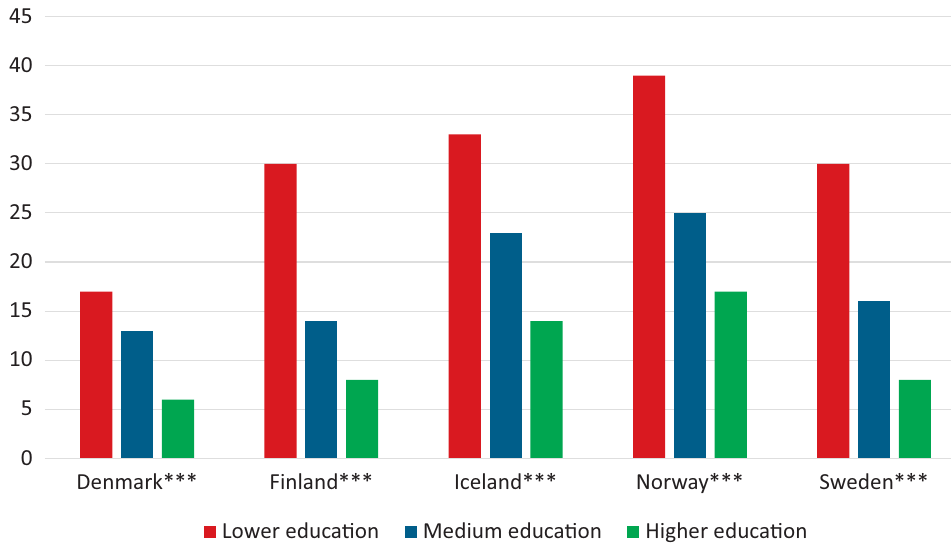
Figure 2. Percentage among different education groups agreeing that “when a mother works for pay, the children suffer” (all age groups, Nordic countries, 2017). Notes: *p < 0.05, **p < 0.01, ***p < 0.001; Denmark: n = 3,233, gamma = − 0.38; Finland: n = 1,164, gamma = − 0.45; Iceland: n = 1,997, gamma = − 0.35; Norway: n = 1,098, gamma = − 0.34; Sweden: n = 1,164, gamma = −